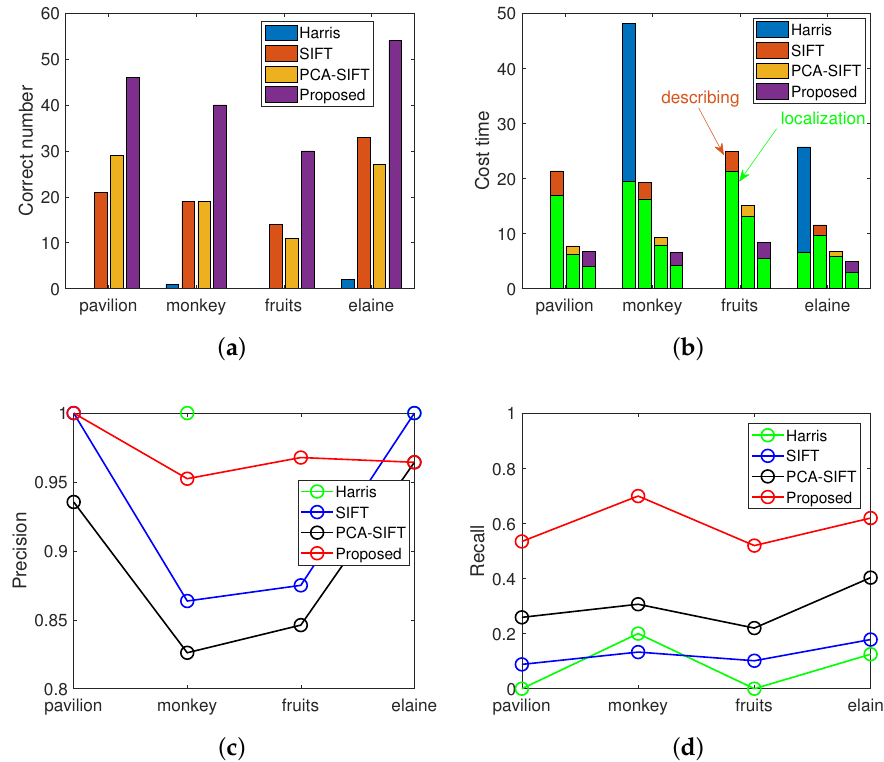
Figure 13. Results analysis of the heterogeneous and noised images matching test: ( a ) correct matching number; ( b ) cost time per match; ( c ) precision of the matches; ( d ) recall of the matches.